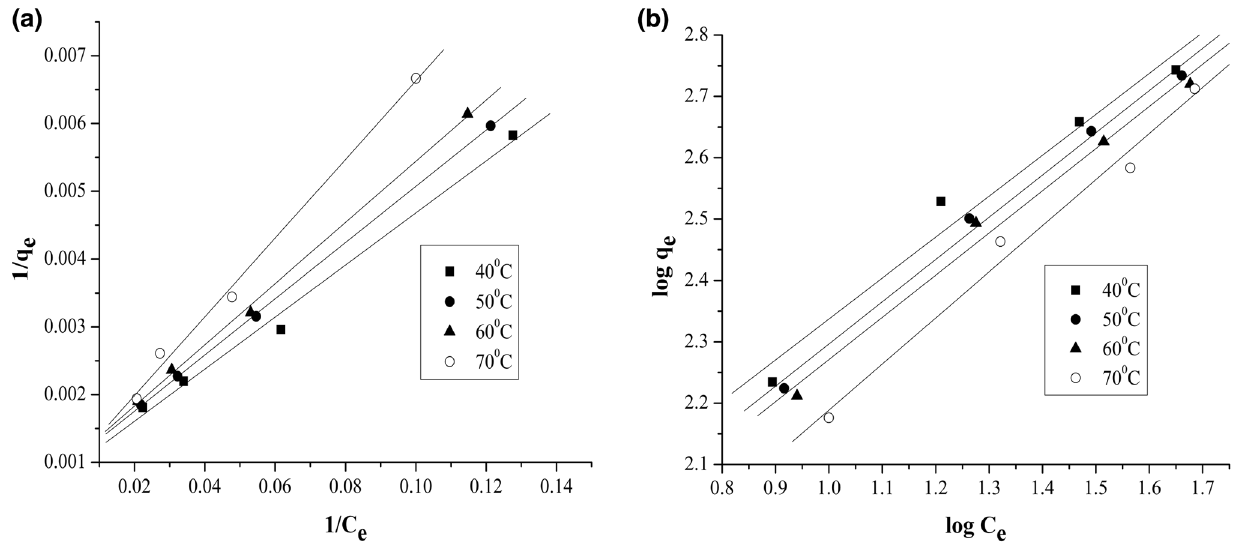
Fig. 2 Adsorption isotherms for RHB at different temperatures. a Langmuir isotherms. b Freundlich isotherms Table 1 Langmuir and Langmuir parameters Freundlich parameters Freundlich parameters for the adsorption of RHB on ABPC Term Values Term Values